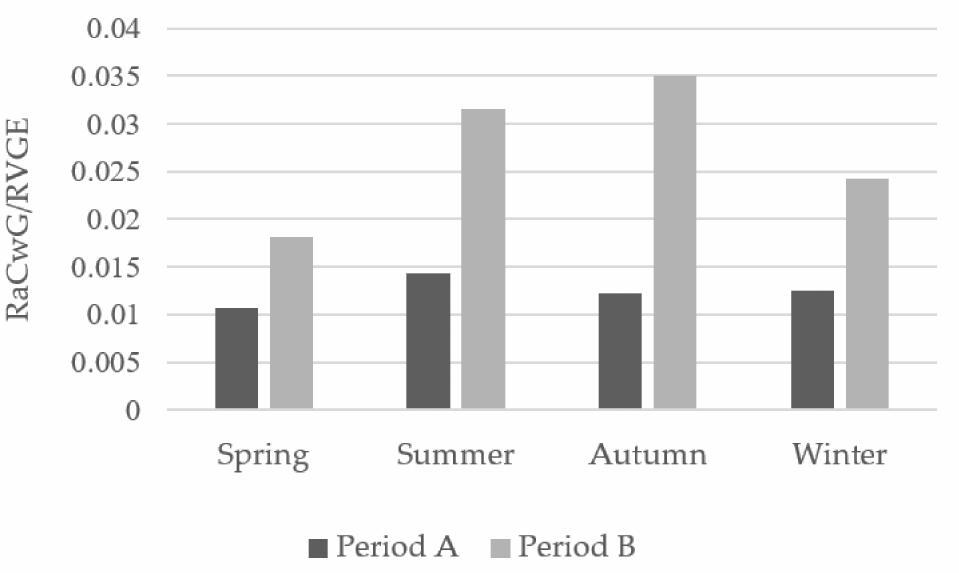
Figure 4. Seasonal between-period comparison of the ratio of RaCwG to RVGE, p = 0.298. RVGE: rotavirus gastroenteritis, RaCwG: rotavirus-associated benign convulsion with mild gastroenteritis, Period A: 2007–2012, Period B: